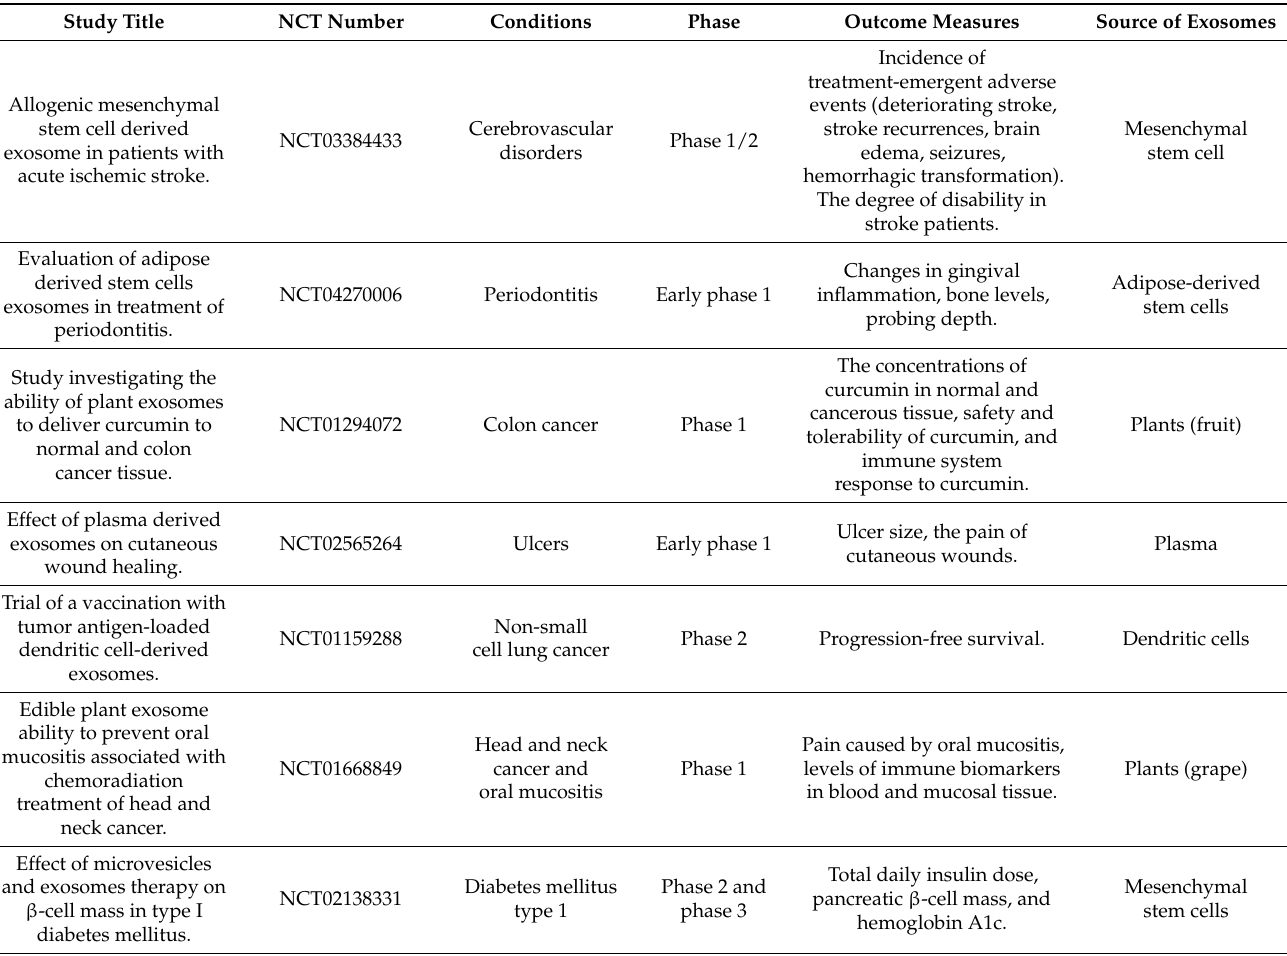
Table 6. List of clinical trials for exosome-based